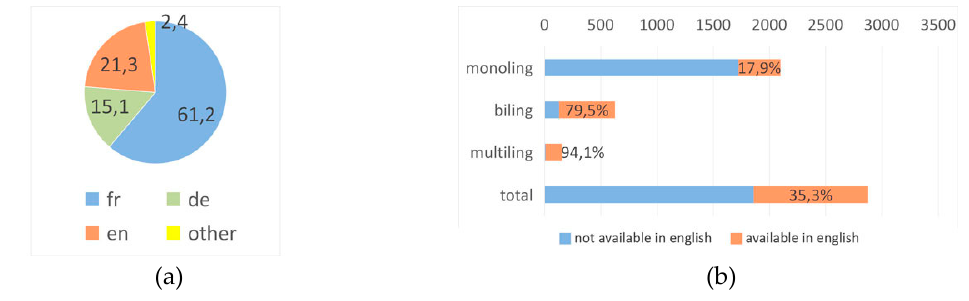
Figure A18. Visualization of the results for domain lu. ( a ) Primary languages pie chart and ( b ) English language availability bar chart.